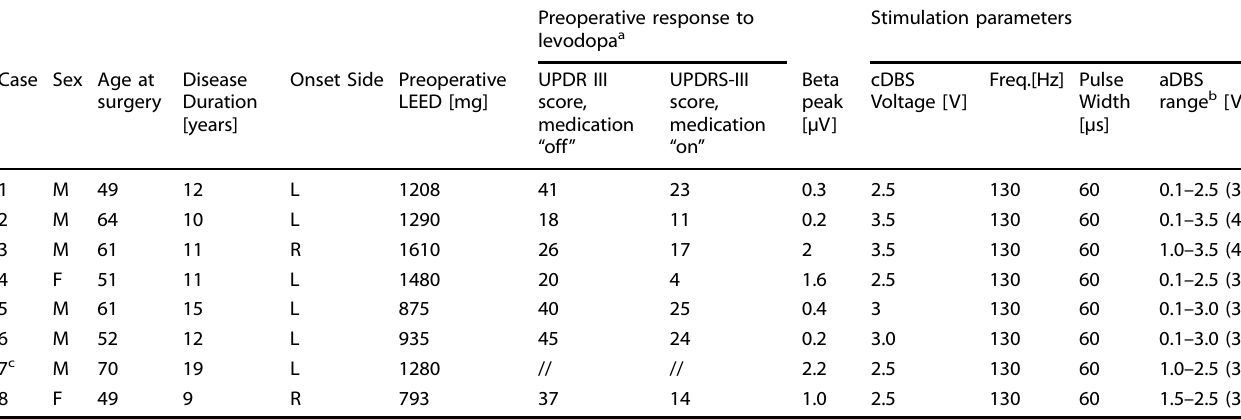
Table 1. Patients ’ experimental